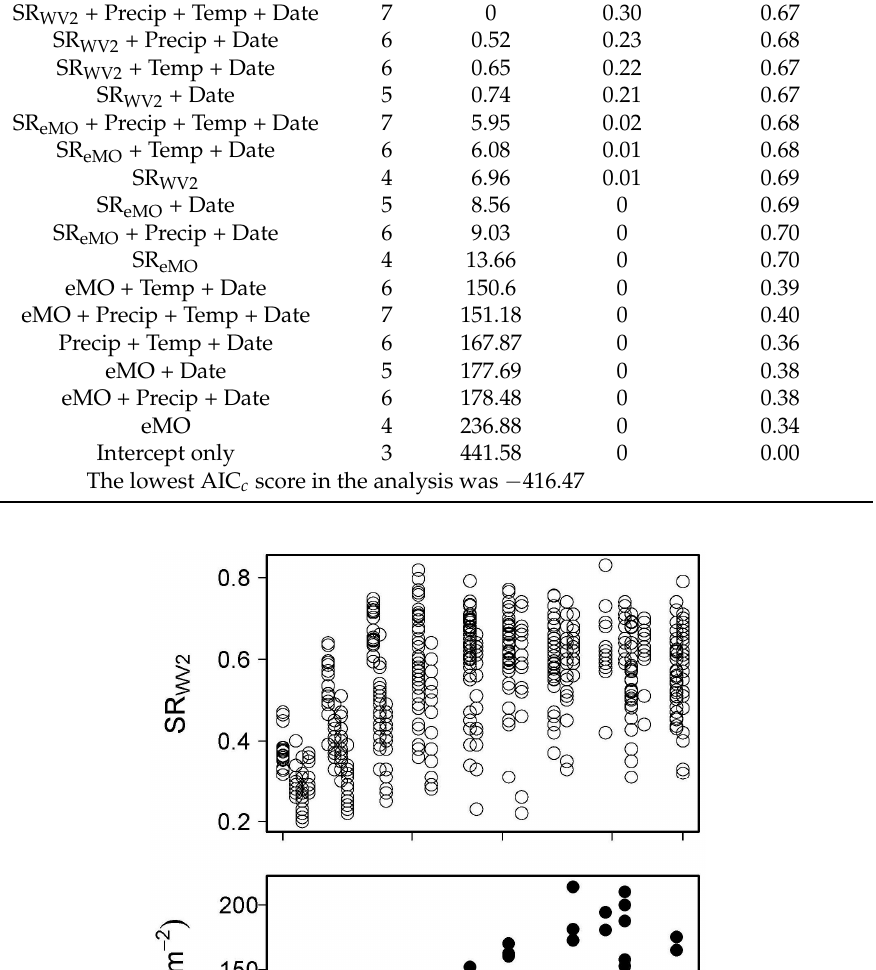
Table 1. Model rankings and marginal R 2 for the relationship between NDVI, precipitation, temperature, date, and forage biomass of halophytic graminoids at the Colville River Delta, Alaska, 2012–2015. NDVI was derived from handheld spectrometers calculated at two band definitions (WorldView-2 (SR WV2 ) and eMODIS (SR eMO )) and from eMODIS satellite (eMO). Precip = cumulative precipitation up to time of sampling, Temp = cumulative temperature up to time of sampling, and Date = Julian date. The number of parameters ( k ) includes +1 k for an intercept, +1 k for residual estimate, and +1 k representing the random effect attributable to unique plots sampled repeatedly across a season. Model k Δ AIC c w i Marginal R 2